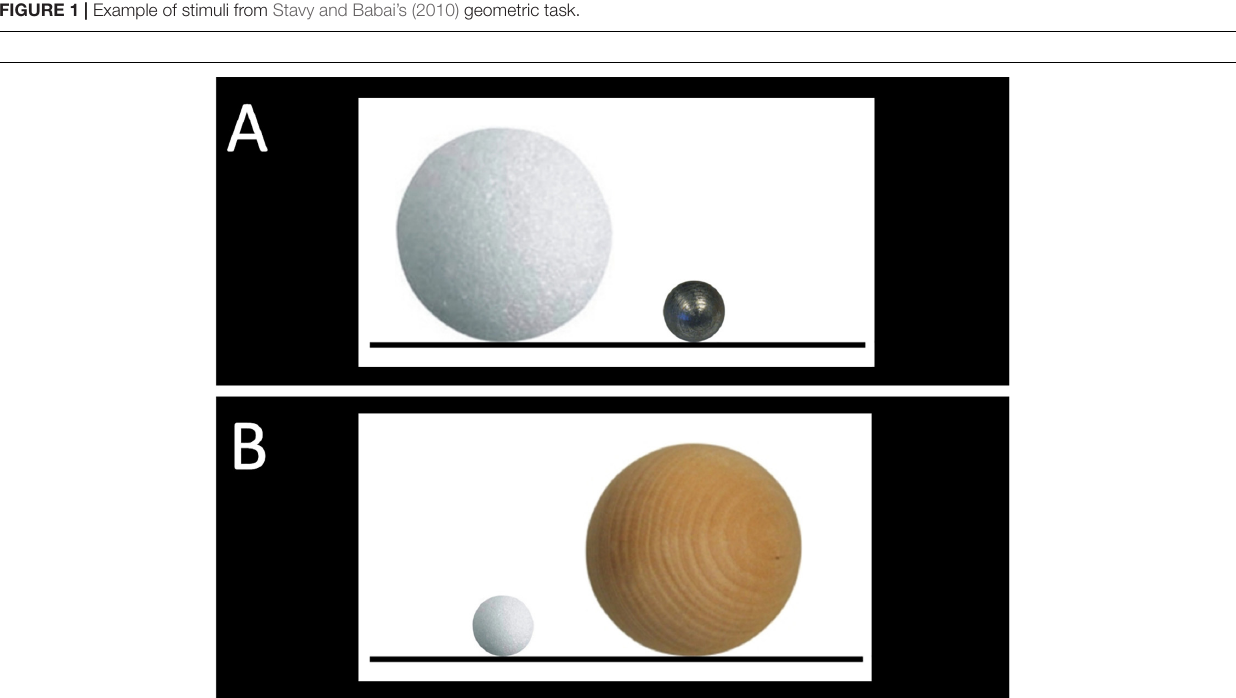
FIGURE 1 | Example of stimuli from Stavy and Babai’s (2010) geometric task.